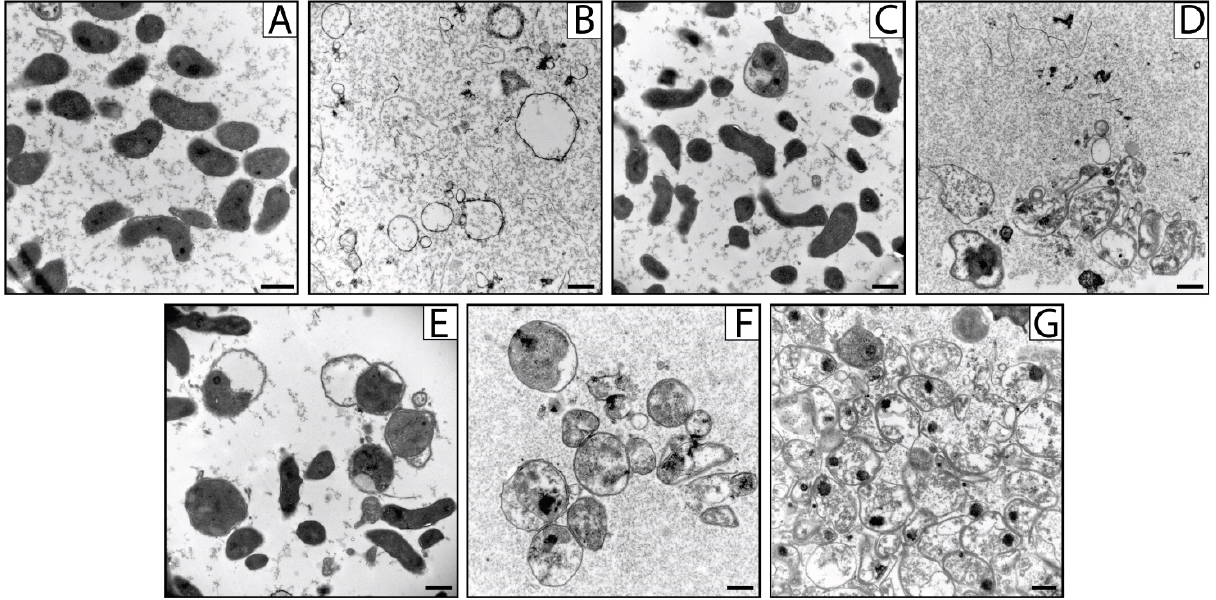
Figure 5. TEM representative images of H. pylori cells untreated ( A ) at 72 h of incubation with CAR ( B ), SHA ( C ) and AMX ( D ) as well as with the combinations CAR ‐ AMX ( E ), SHA ‐ AMX ( F ) and CAR ‐ SHA ( G ) at MIC concentrations. Scale bars: 500 nm.